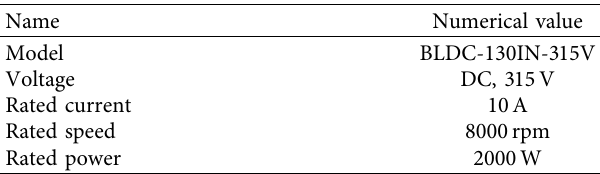
Figure 9: Three-support rotor test platform: (a) speed control device; (b) computer; (c) signal acquisition device; (d) multispan rotor test bench. Table 8: Motor parameters.